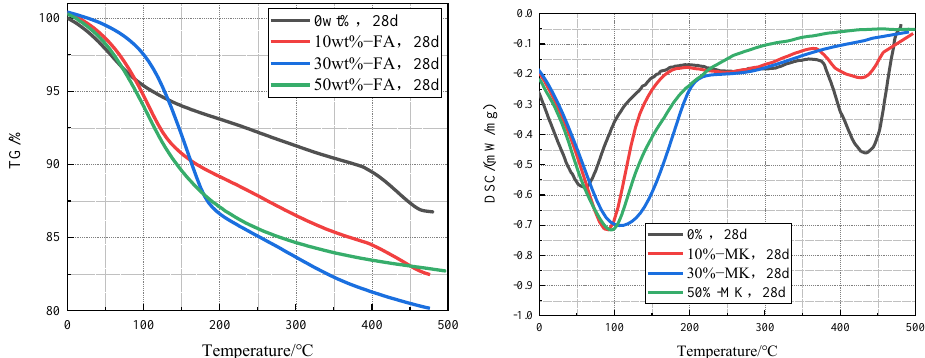
Figure 8. TG-DSC curves of cement pastes containing 0%, 10%, 30%, and 50% metakaolin after curing at 20 °C for 28 days.